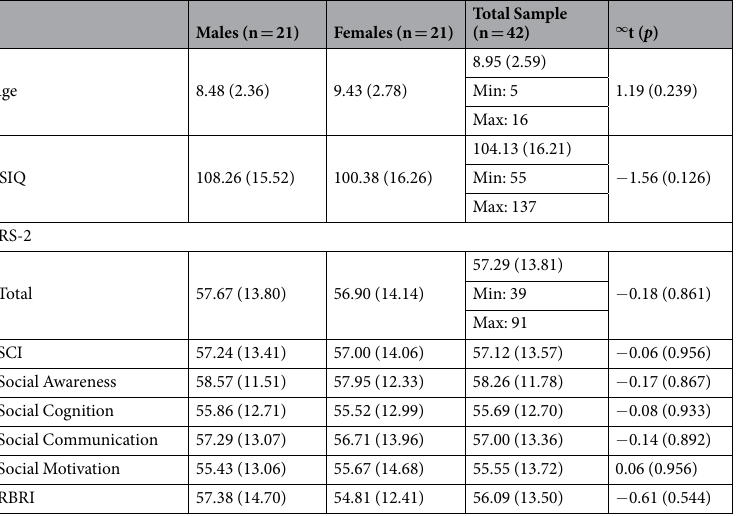
Table 3. Means (SDs) of demographic and behavioral data. ∞ T-scores indicate results from group comparisons (male and female) across Full Scale IQ (FSIQ) and SRS-2 scores. There were no significant differences between males and females (p < 0.05) in age, FSIQ, and SRS-2